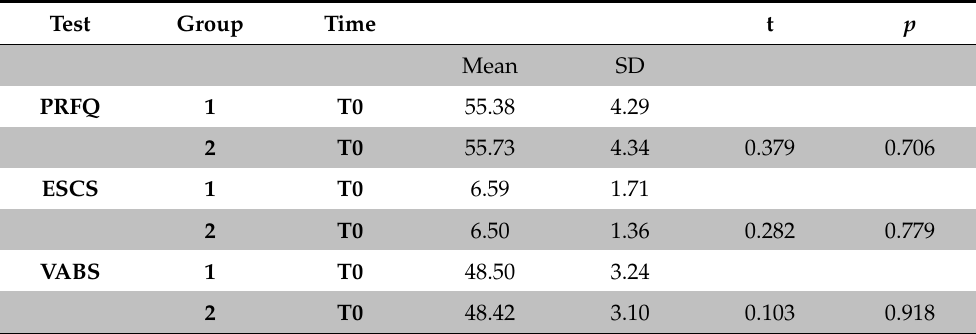
Table 1. Comparison of the two groups at T0